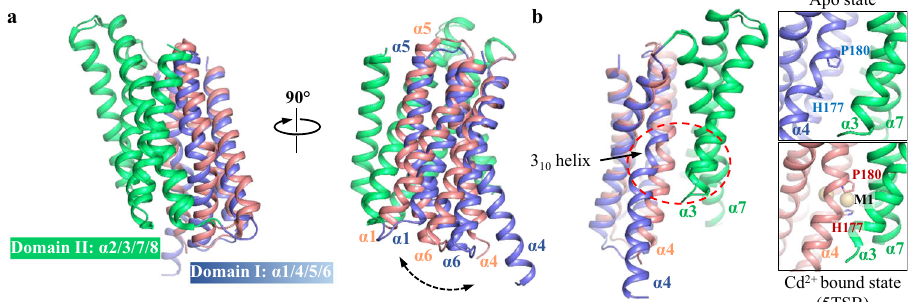
Fig. 3 | Two-domain architecture revealed by structural comparison between theapostateandthesubstrateboundstateofBbZIP.a Structuralalignmentvia DomainII.Arigid-bodyrotationofDomainI(bluefortheapostateandpinkforthe substrateboundstate)againstDomainIIwasunraveled.Forclarity, α 0and α 0aare